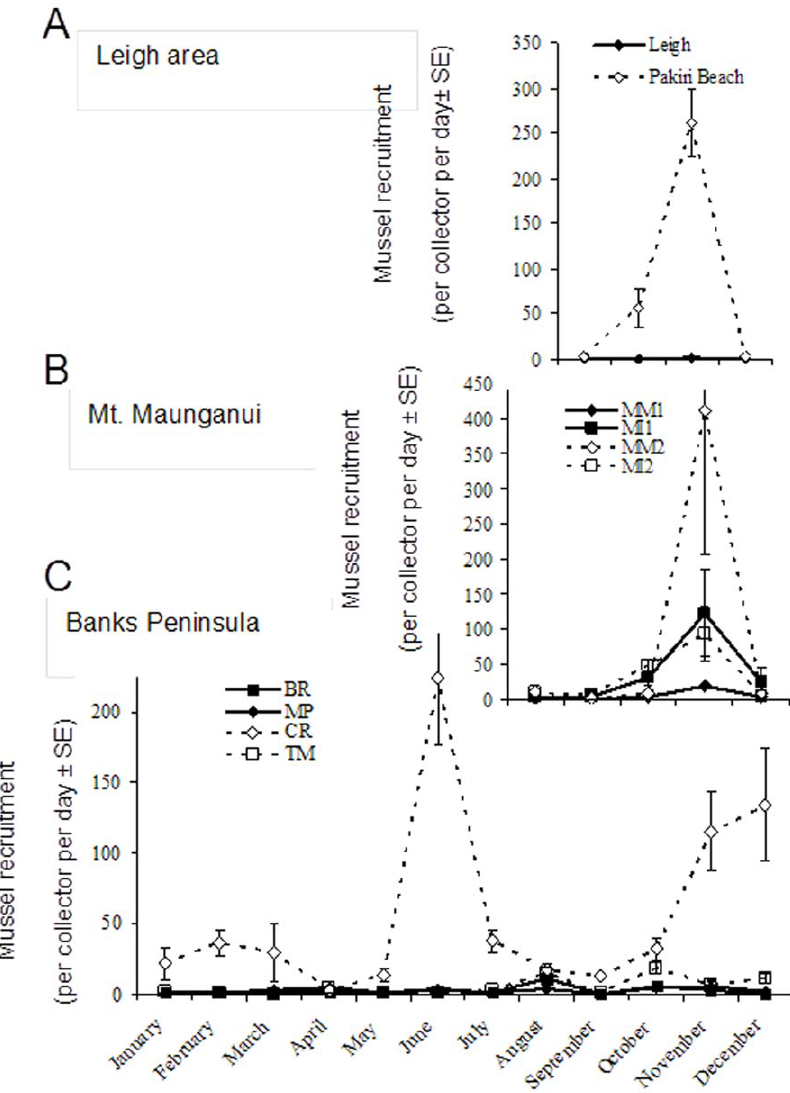
Figure 3. Mussel recruitment rates (mussels per collector per day) at R-R and R-S sites. From north to south (a) Leigh area sites, (b) Mt. Maunganui sites, (c) Banks Peninsula sites. Open symbols/dashed lines designate R-S sites and full lines / black symbols designate R-R sites. For Banks Peninsula sites we used data from a previous experiment [27] because in the current study we only used no-cage treatments in this region (not allowing the measurement of effect-size) but the results from the two experiments show very similar trends.